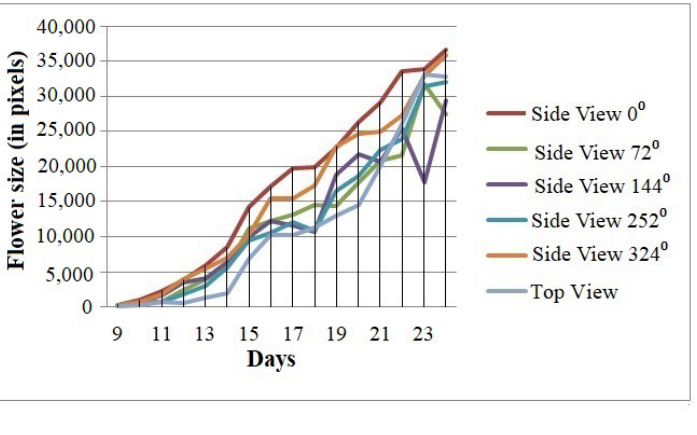
Figure 18. Illustration of the growth trajectory of a coleus flower in multiple views (Plant-ID: